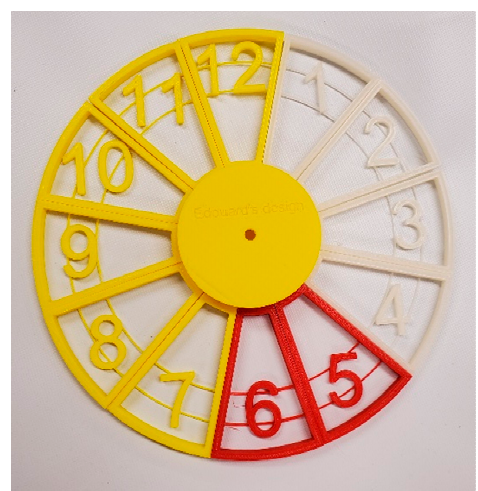
Figure 4. Clock model [65].